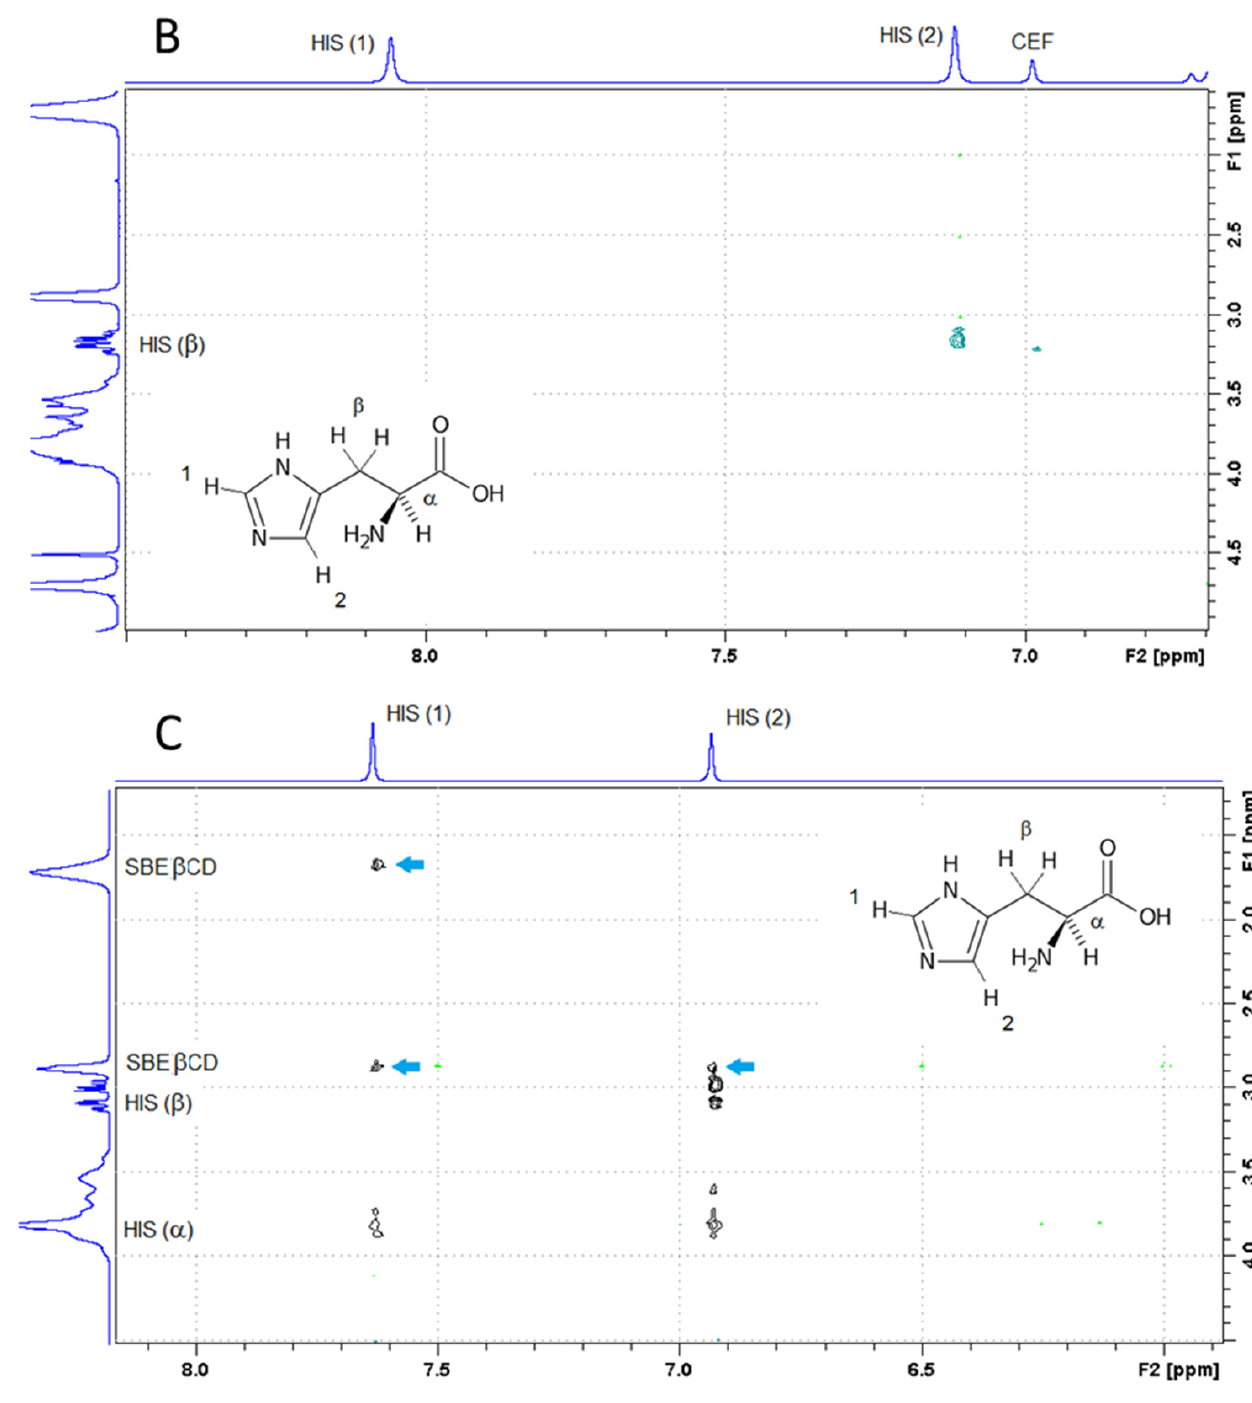
Figure 5. 2D ROESY spectra of ternary CEF:His:SBE β CD ( A , B ) and binary His:SBE β CD ( C ) solutions.